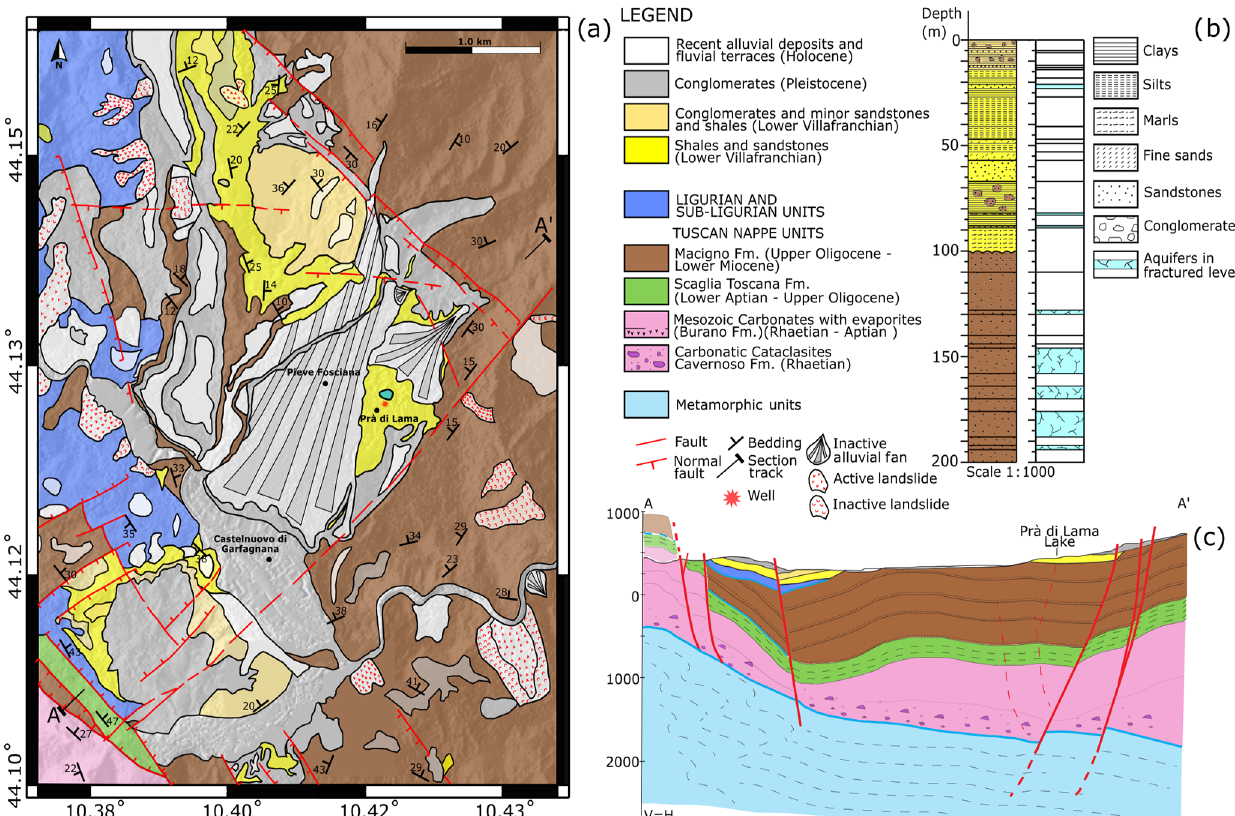
Figure 2. Geological setting of the study area. (a) Geological, structural and geomorphological map of the area nearby Prà di Lama showing the main tectonic and lithostratigraphic units. (b) Schematic sedimentary sequence of the Villafranchian deposits obtained from the well drilled at Prà di Lama (modified from Chetoni, unpublished data). (c) Stratigraphic cross section across the Garfagnana